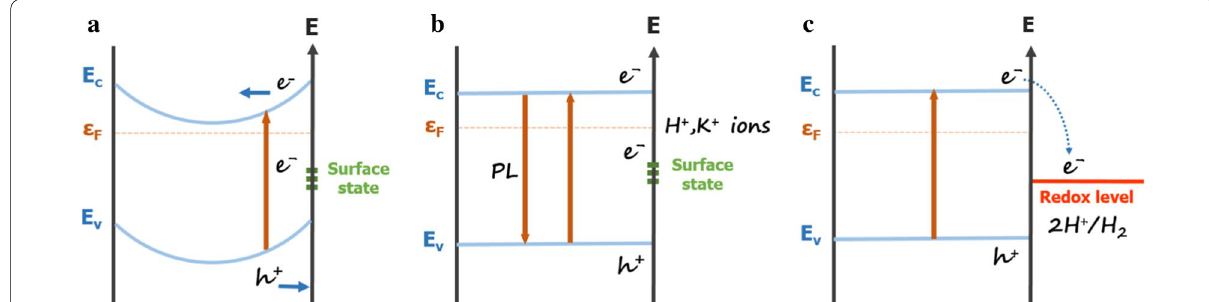
Fig. 2 Schematic illustration of the effect of ion concentration on photoluminescence intensity. E is energy. E c , E v , and ε F are conduction band edge, valance band edge, and Fermi level respectively. a Surface depletion region caused by the trapped electrons in the surface states. b Depletion region neutralized by the attachment of positives ions H + or K + . c Electron transfer to the redox level of H